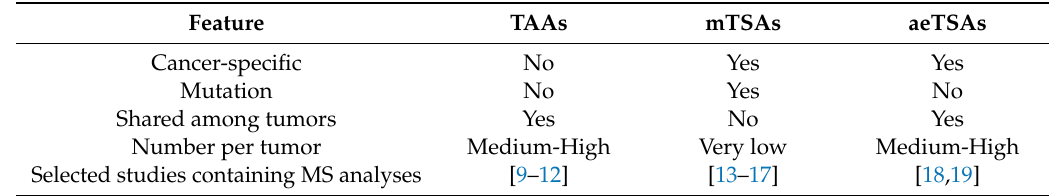
Table 1. Features of tumor